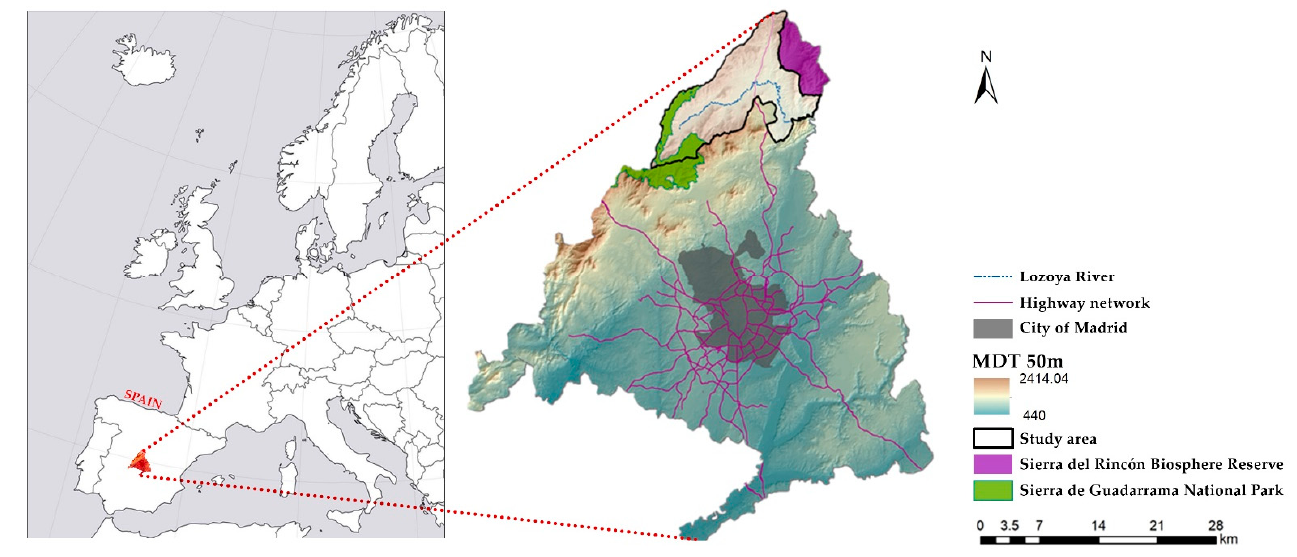
Figure 1. Map of the Madrid Region with the Lozoya Valley area of study in the north.